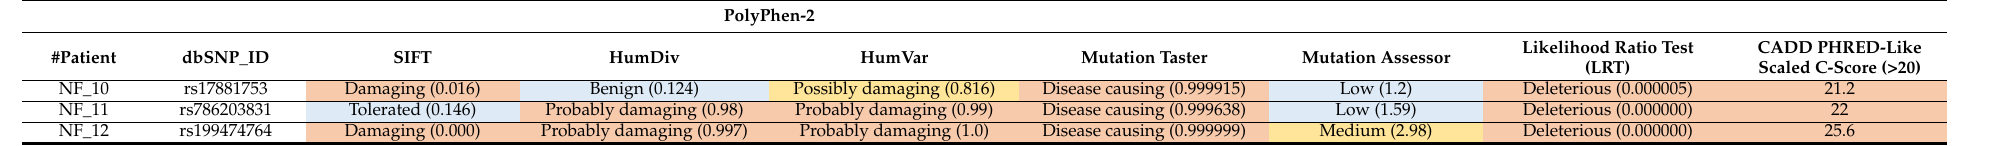
Table 4. Summary of the in silico analysis for missense variants with unknown